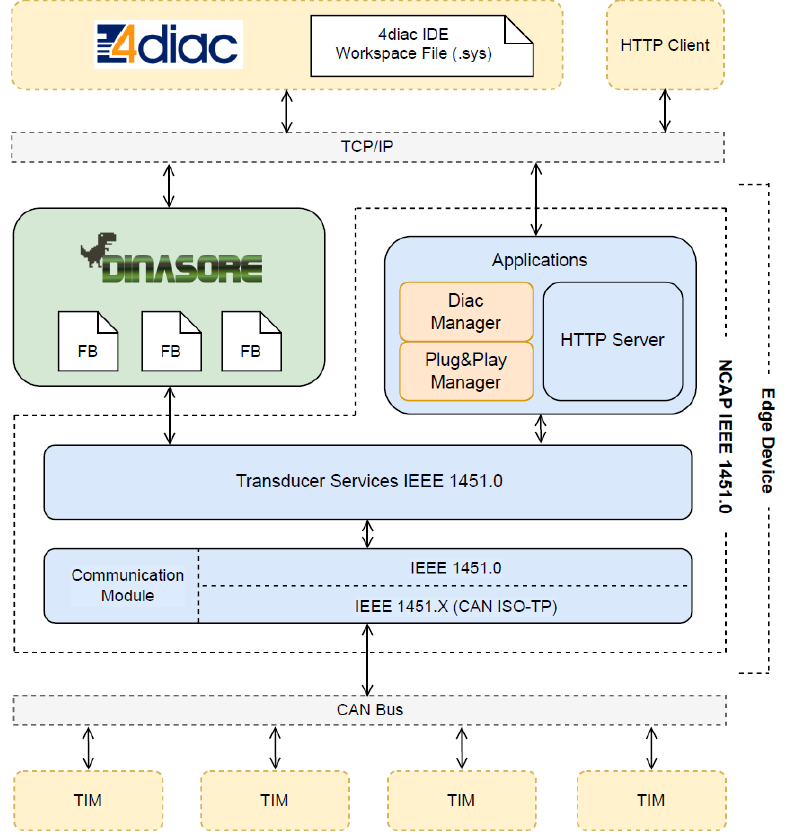
Figure 6. Edge Device